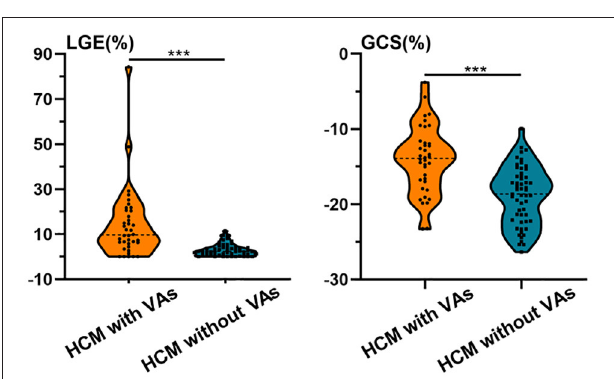
FIGURE 4 | Violin plots of %LGE and GCS in HCM patients with and without VAs. HCM patients with VAs had worse GCS and increased %LGE compared with those without VAs. Asterisks denote P < 0.001. GCS, global circumferential strain; HCM, hypertrophic cardiomyopathy; LGE, late gadolinium enhancement; VA, ventricular